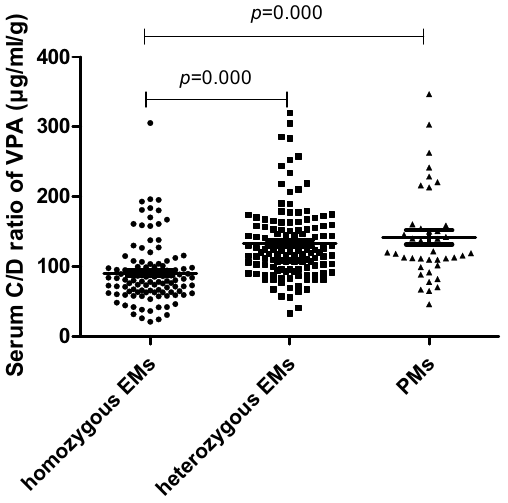
Figure 1. Differences in serum concentration/dose ratio of valproic acid in various metabolizer of CYP2C19 in Chinese schizophrenia patients. EMs: extensive metabolizers; PMs: poor metabolizers.